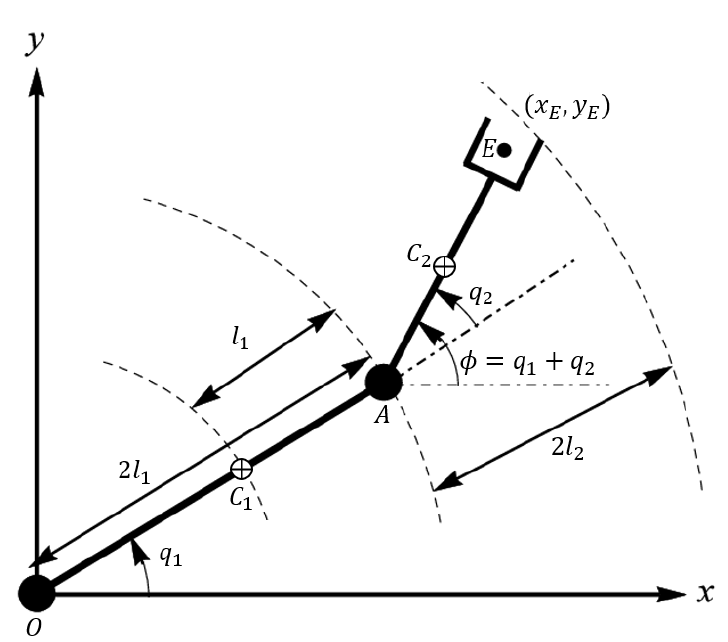
Figure 3. Schematic representation of a 2R planar robot.